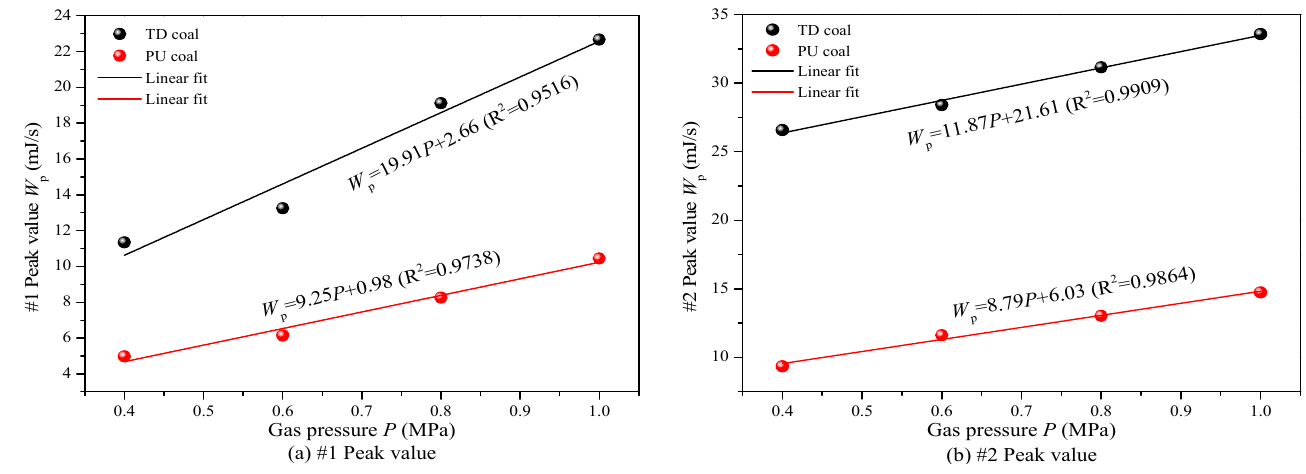
Figure 12. Relationship between the peak value of gas expansion energy and gas pressure.